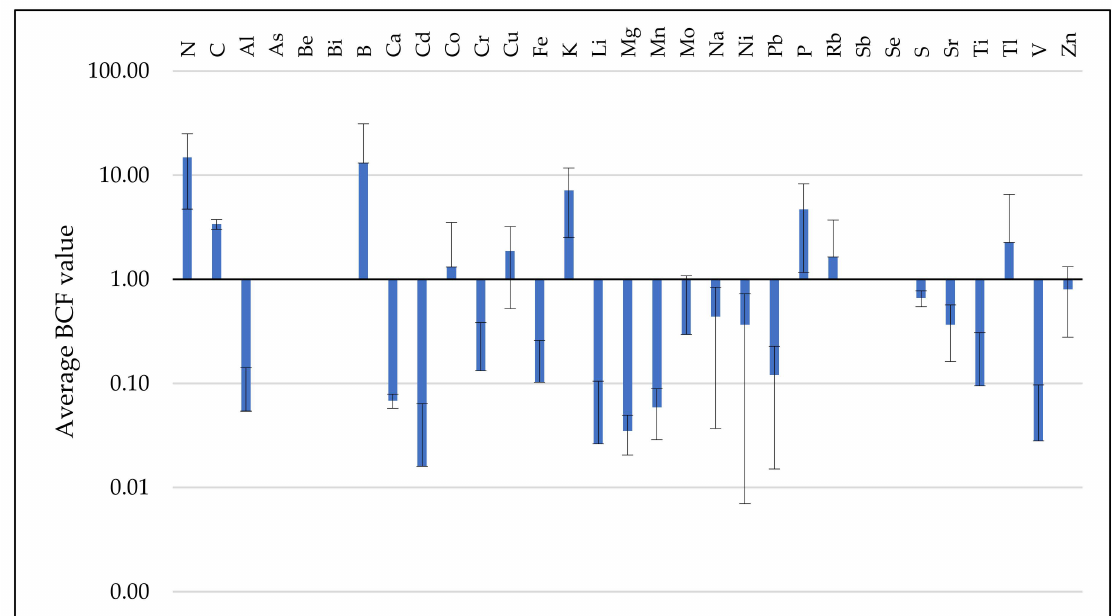
Figure 4. Average values of BCFs, and their corresponding standard deviations, obtained from the total